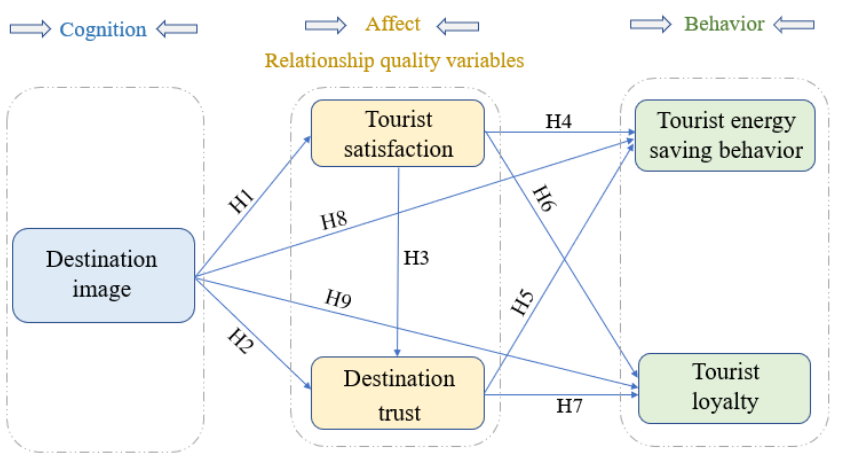
Figure 1. Conceptual model.